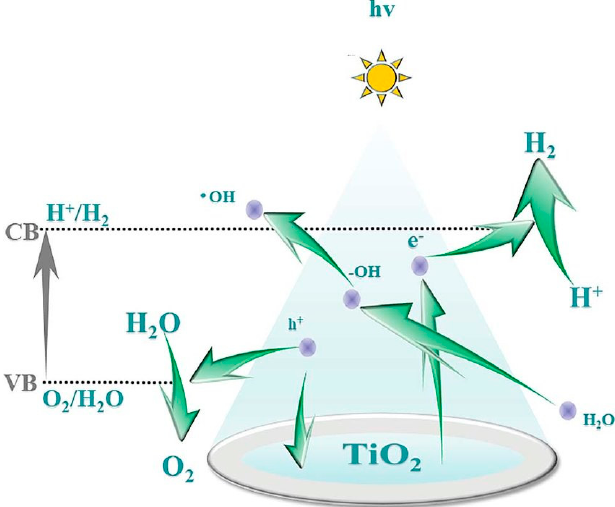
Figure 2. Mechanism of photocatalytic water splitting for hydrogen production [6].